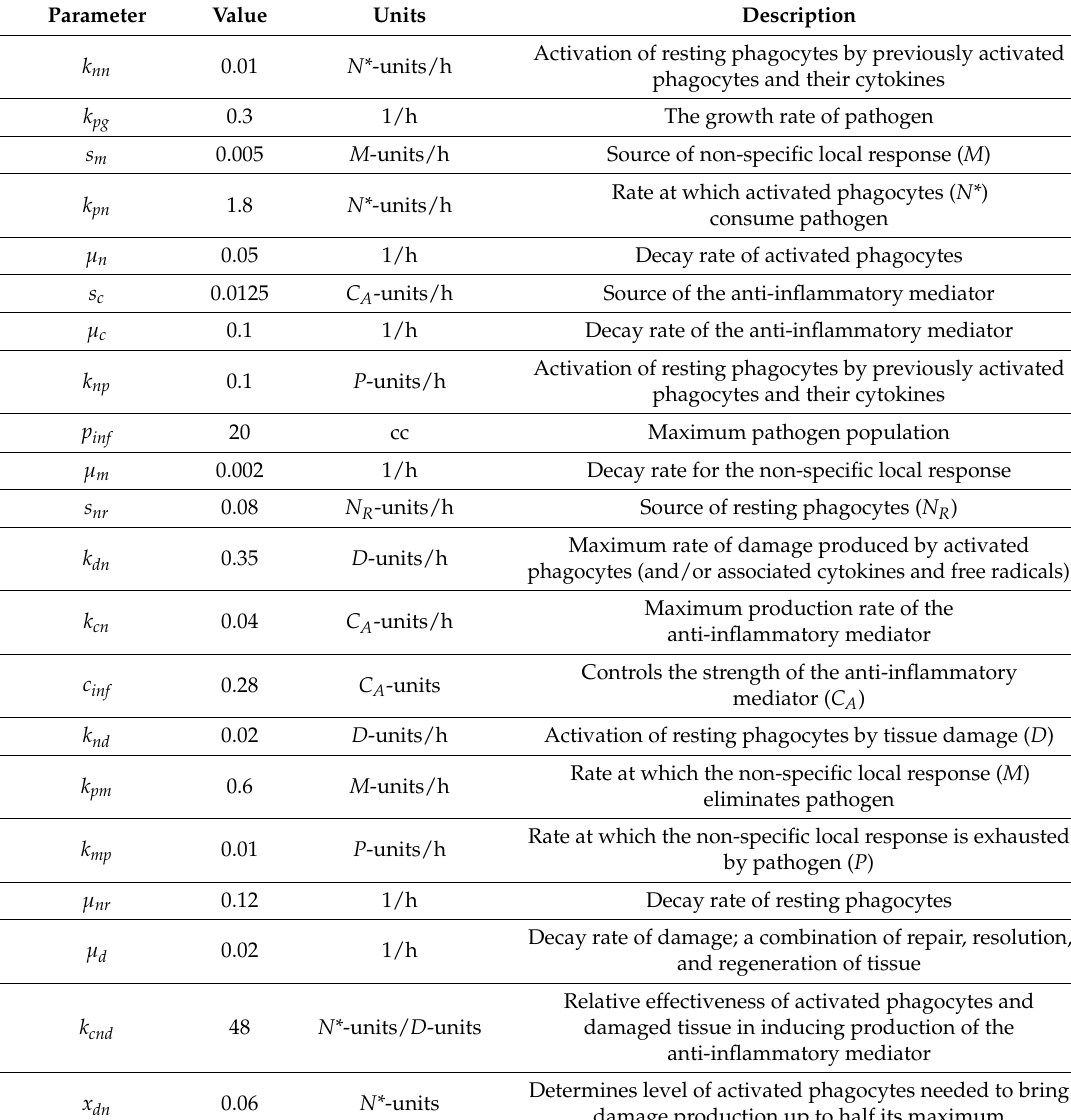
Table 1. Parameter values used in all model simulations, as reported in [17].